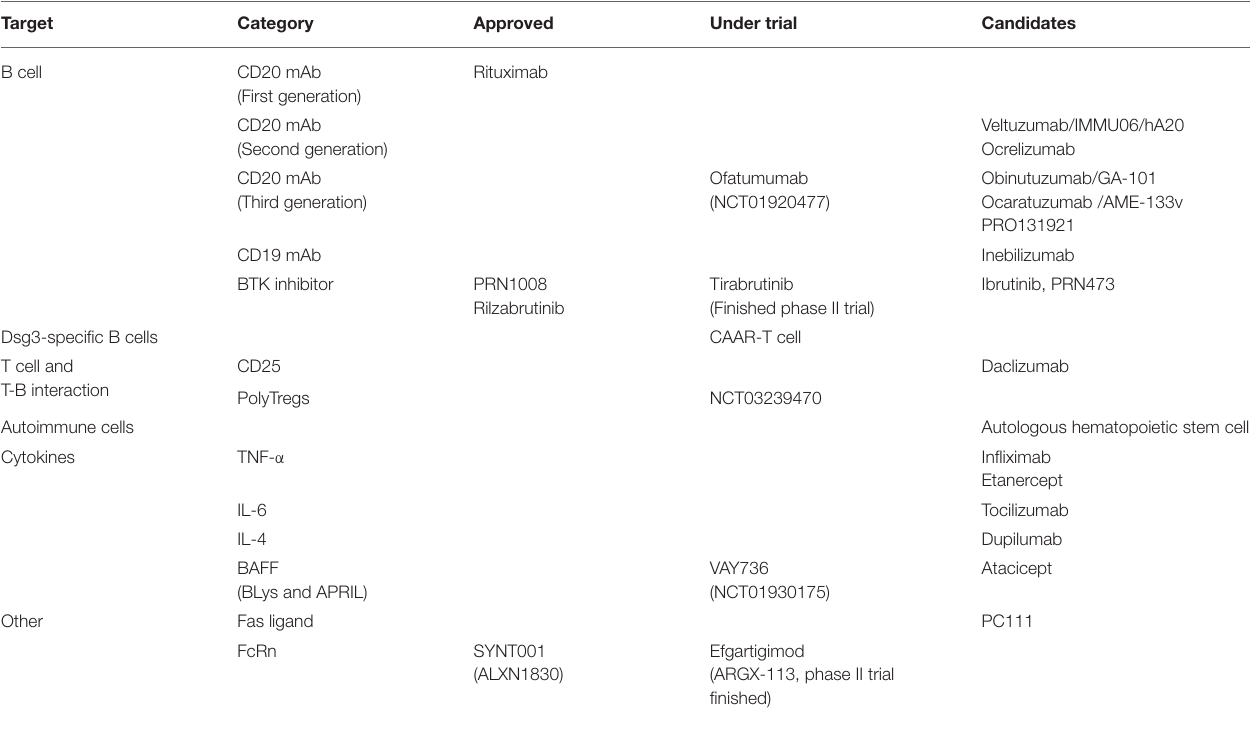
TABLE 1 | Biological agents of immunotherapy and their status of clinical trial for pemphigus.